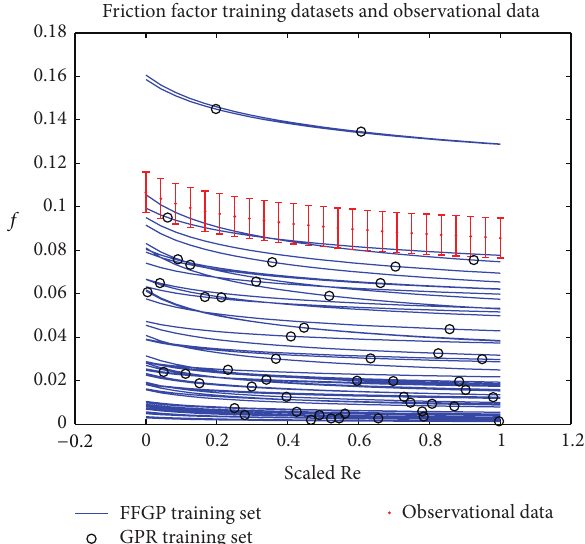
Figure 6: Two uncertain input demonstration training sets.